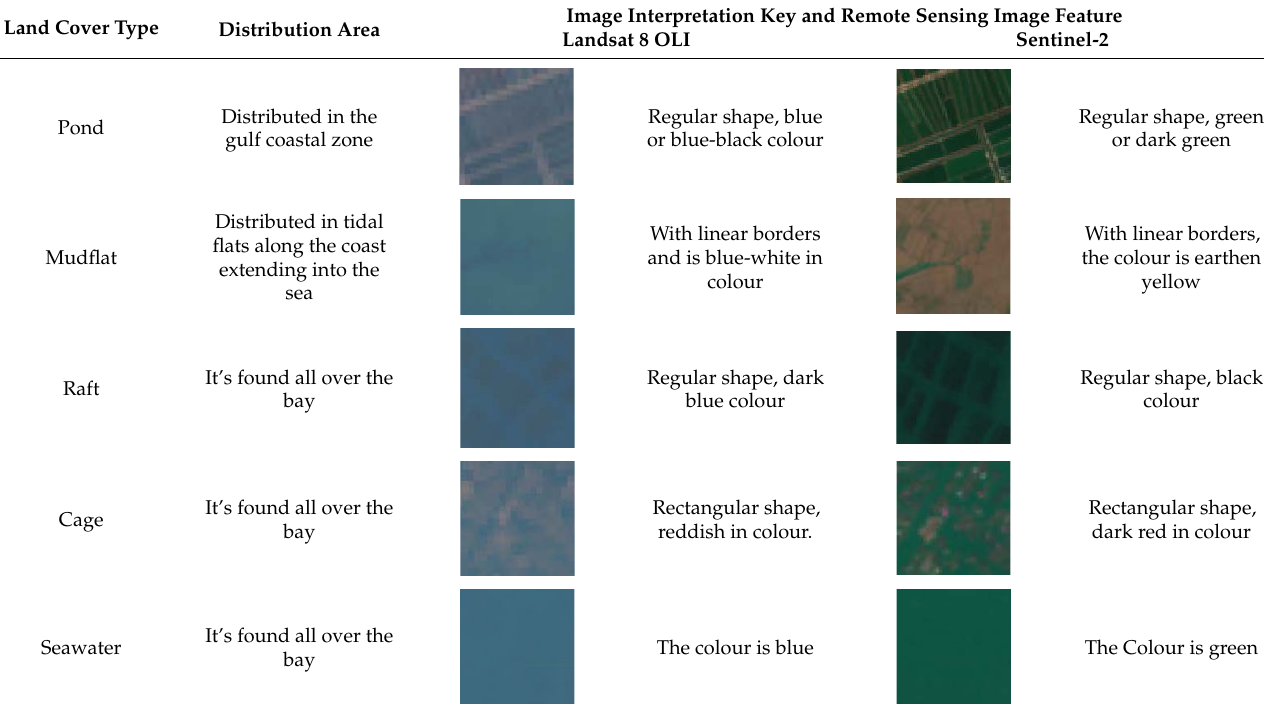
Figure A8. Plot showing changes in maricultural in counties in the study area including ( A ): Dongshan, ( B ): Zhao’an, and ( C ): Yunxiao. Table A1. Remote sensing interpretation marks .